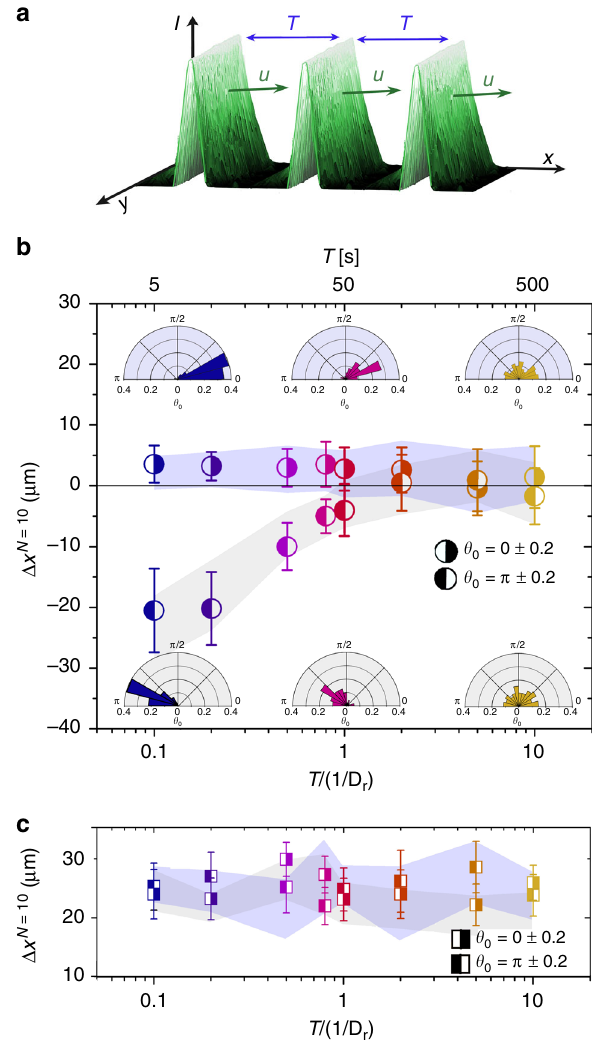
Fig. 4 Response of APs to periodic pulse trains. a Measured intensity pro fi le of a train of light pulses with T the time intervals between the pulses and u the pulse velocity. b Total AP displacement Δ x N ¼ 10 after interaction with 10 = 1 and w = 4 σ . Symbols (experimental data) pulses with u = v max p correspond to different initial AP orientations θ 0 (see legend) and numerical simulations (shaded areas). The insets show the probability distributions of the particle orientation prior to each pulse within the train for T /(1/ D r ) = 0.1 (blue), 0.6 (pink), 10 (yellow). c Corresponding Δ x N ¼ 10 = 0.875 for w = 4 σ . Symbols (experimental data) correspond to for u = v max p different initial AP orientations θ 0 and numerical simulations (shaded areas). All experimental data averaged over at least 20 realizations